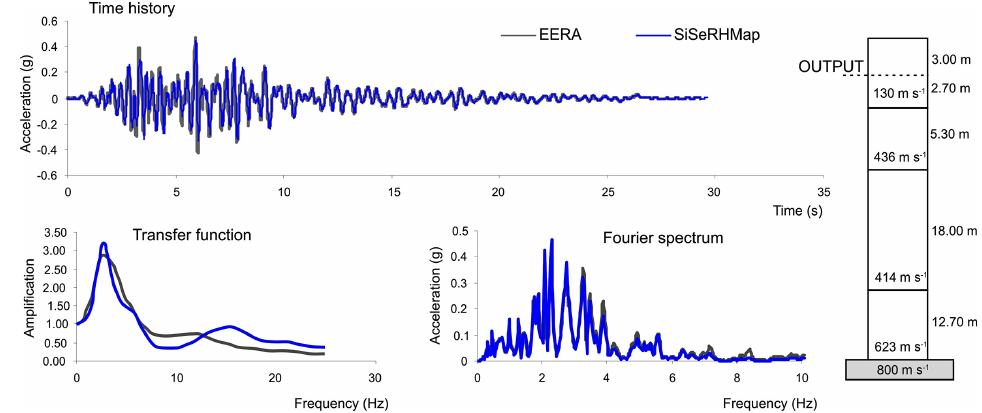
Figure 5. Comparison between EERA and SiSeRHMap (mod.3, stratigraphic response) on a 1-D model related to the third trainer V S – h model regarding zone